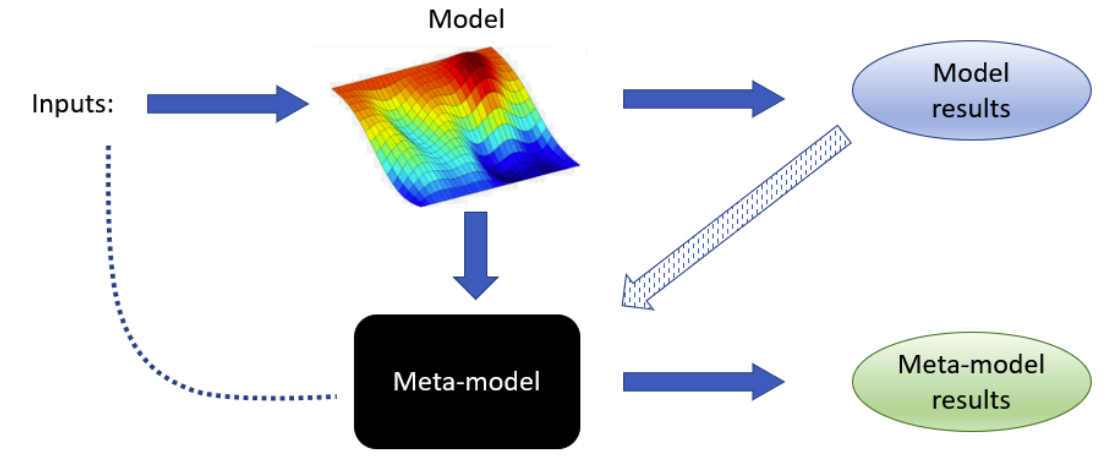
Figure 1. Meta-modeling construction